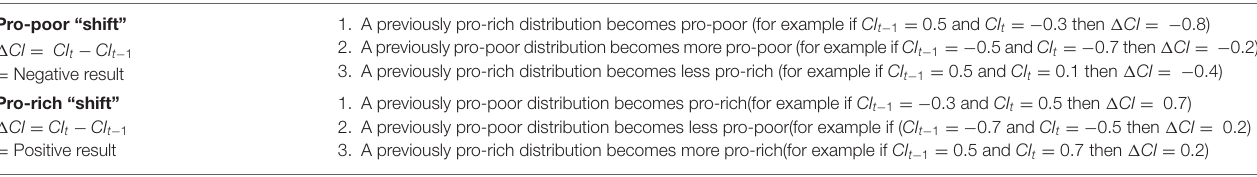
TABLE 2 | Explaining a pro-poor and a pro-rich shift in the concentration index between two time periods. Pro-poor